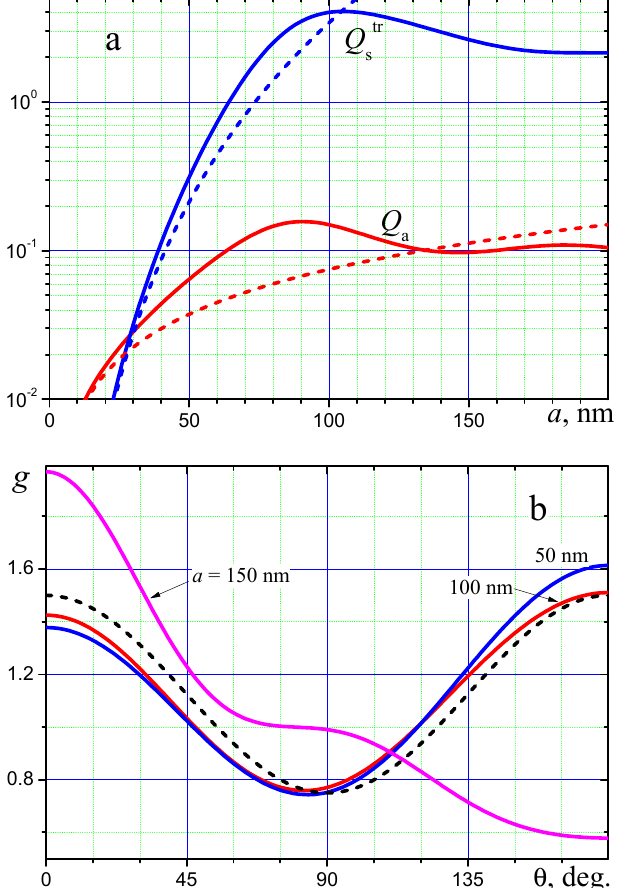
Figure 6. Optical properties of spherical copper particles at wavelength 𝜆 = 660 nm: ( a )—the efficiency factor of absorption and transport efficiency factor of scattering, ( b )—the scattering phase function of single scattering. Solid lines—the Mie theory, dashed lines—the Rayleigh theory. The angle of scattering is measured from the direction of incident light.